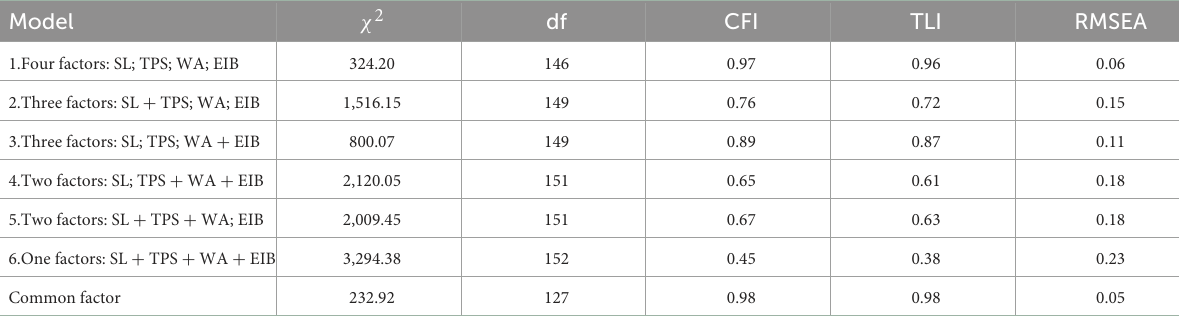
TABLE 2 Confirmatory factor analysis and model comparison.